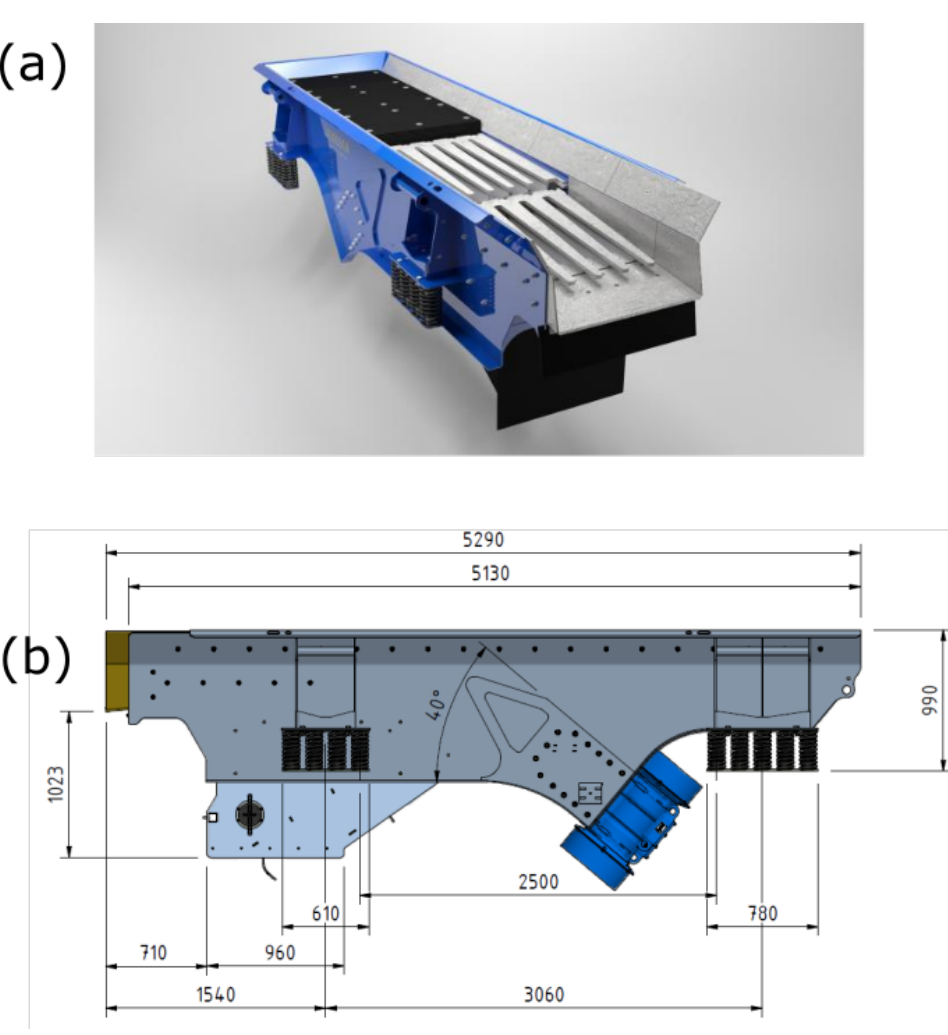
Figure 2. ( a ) Showing a 3D picture of the P.J Jonsson feeder. The grizzlies (looks like teeth) observed are not present in the feeder in the present study. Instead, only steel plates are used. Overall dimensions can be seen in ( b ), the length of the feeder is 5.3 m and the width is 1.8 m. The direction of movement is 40 ◦ from the horizontal plane as observed in the figure. Pictures adopted from P.J Jonsson with